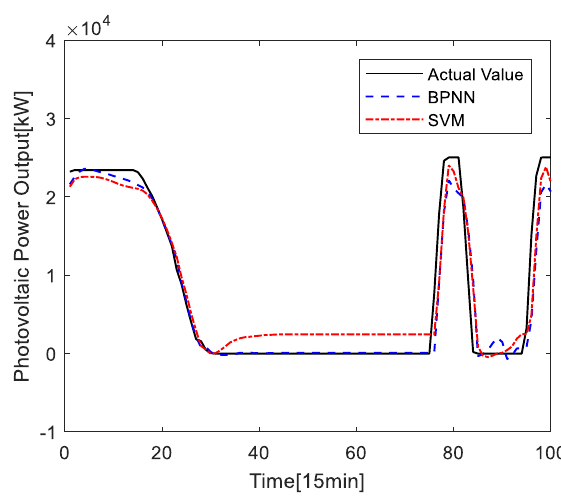
Figure 13. Prediction results of the photovoltaic power output in the No. 1 power system.